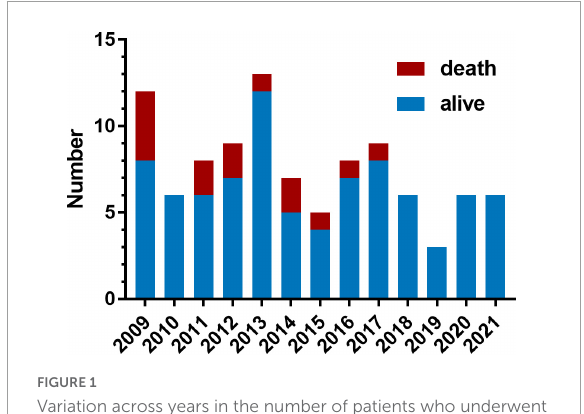
FIGURE1 Variation across years in the number of patients who underwent truncus arteriosus (TA) repair and the early mortality. Each bar contains the number of patients who suffered operative mortality (red portion) and the number of patients who survived (blue